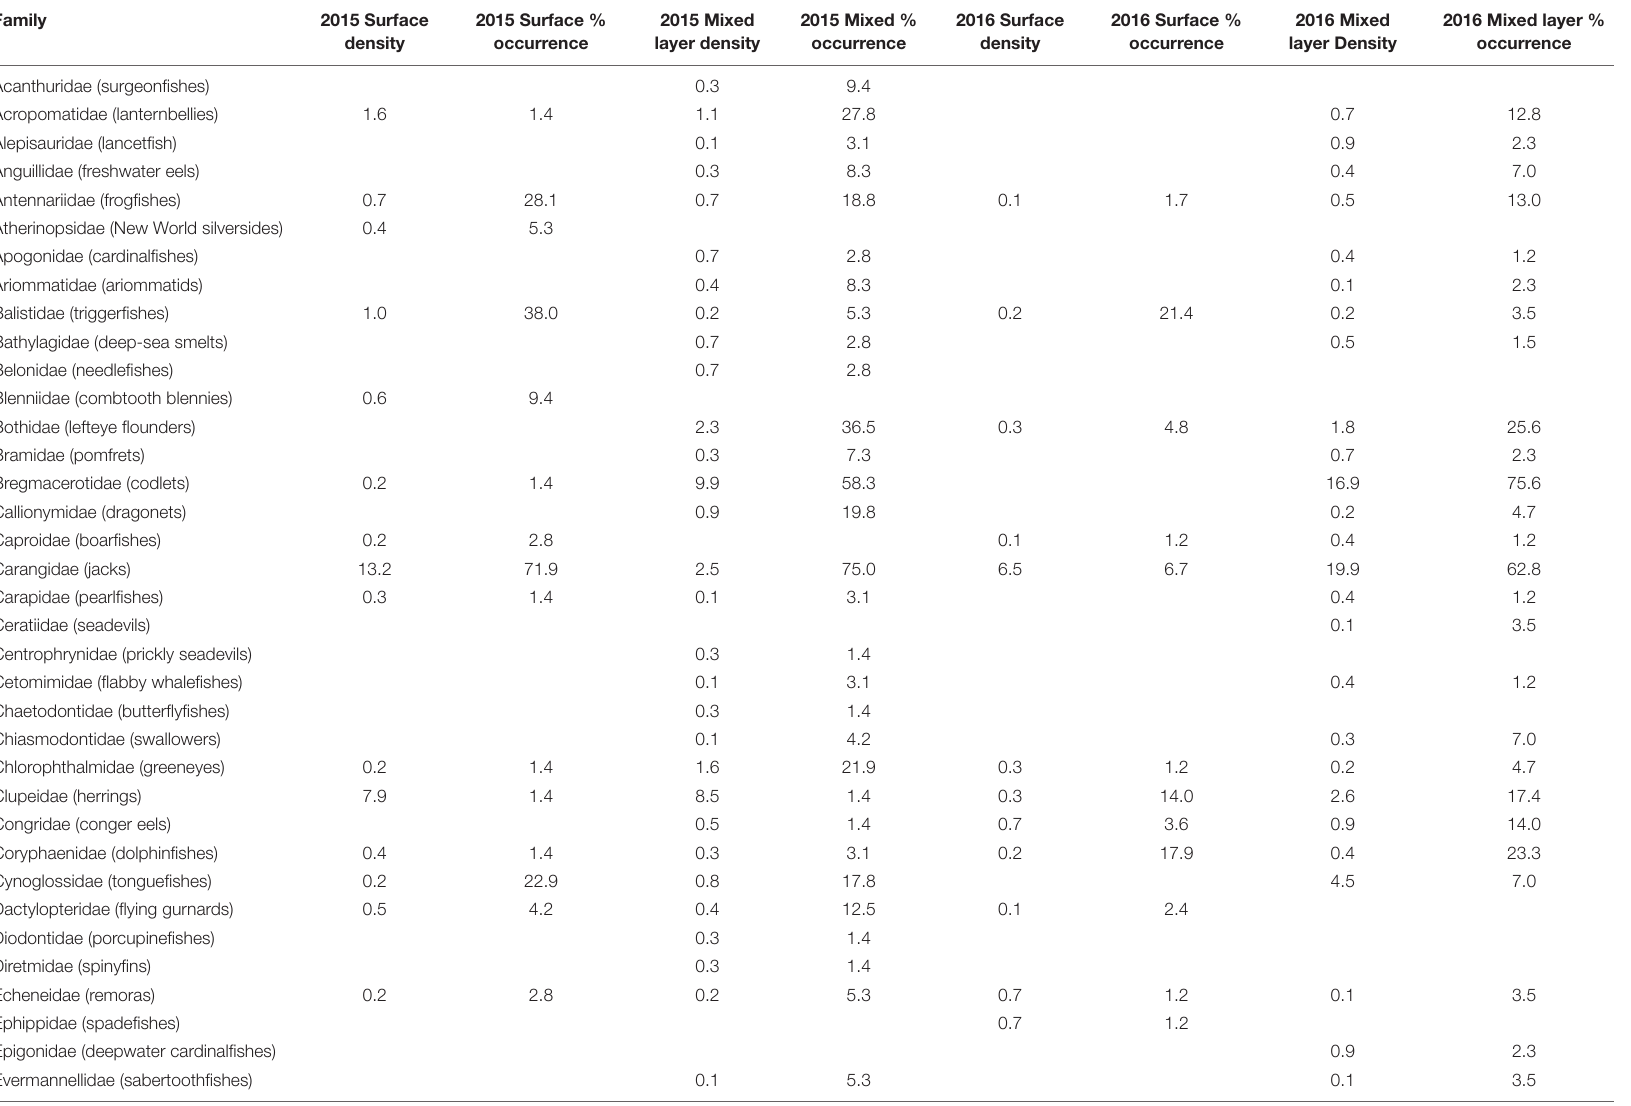
TABLE 1 | Catch data of larvae in the northern Gulf of Mexico in 2015 and 2016 from surface (0–1 m with neuston tows) and mixed layer (0–100 + m with oblique bongo tows).